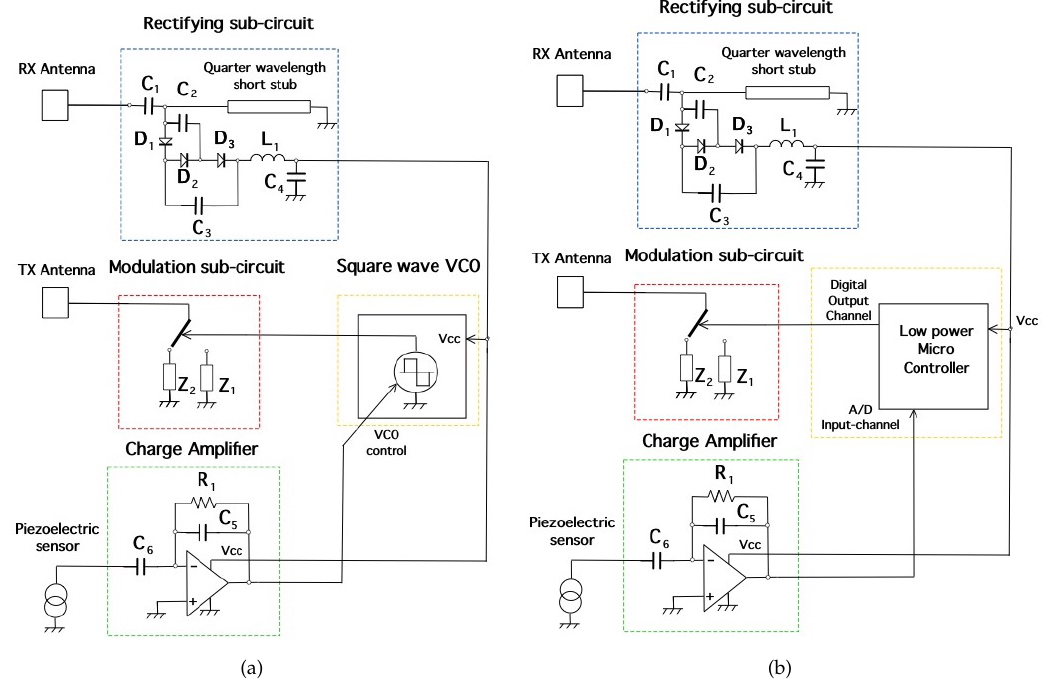
Figure 4. Tag schemas. Tag equipped with ( a ) VCO and ( b ) Microcontroller.